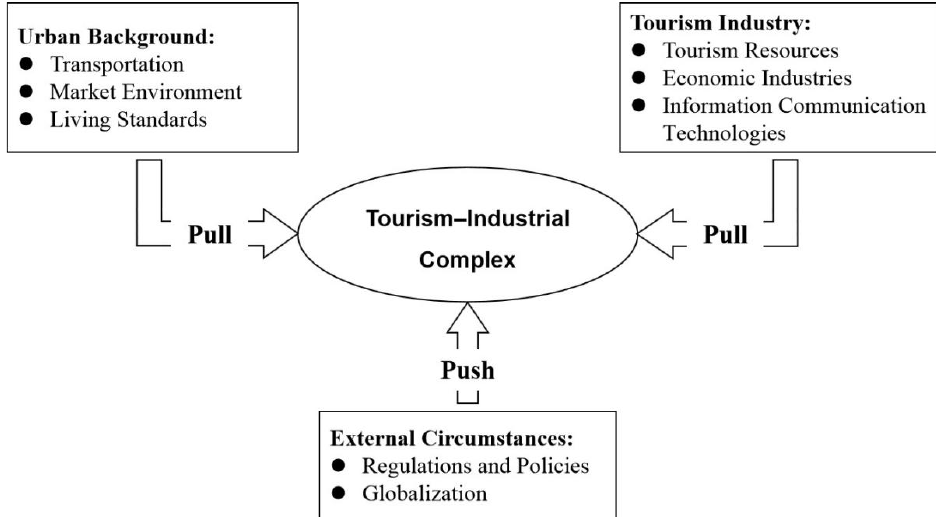
Figure 5. Dynamic mechanism of the urban tourism–industrial complex.